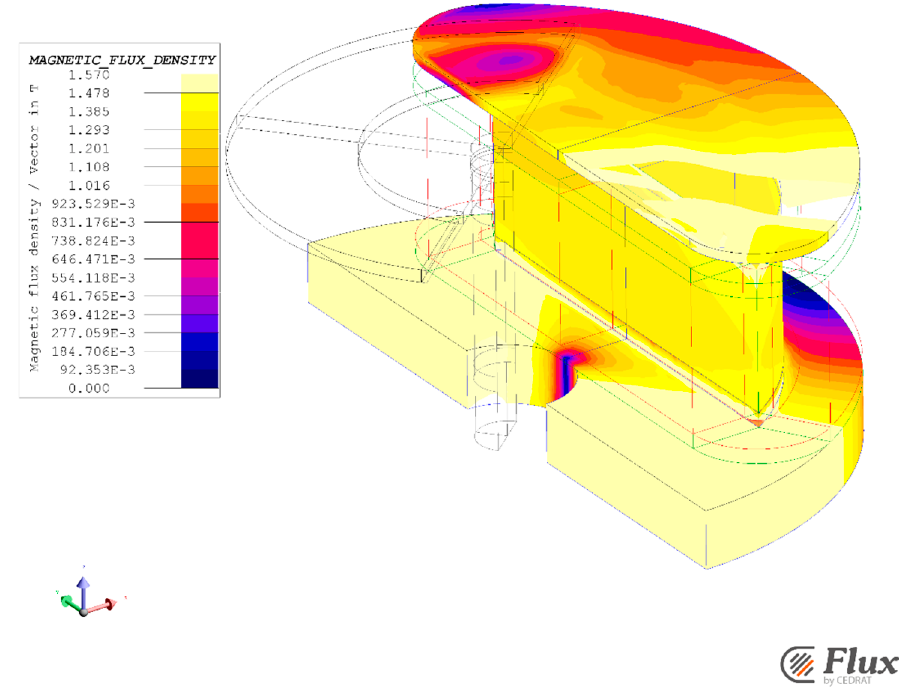
Figure 11. Magnetic flux density in core at the 130° rotor position and the 5.72 A current.